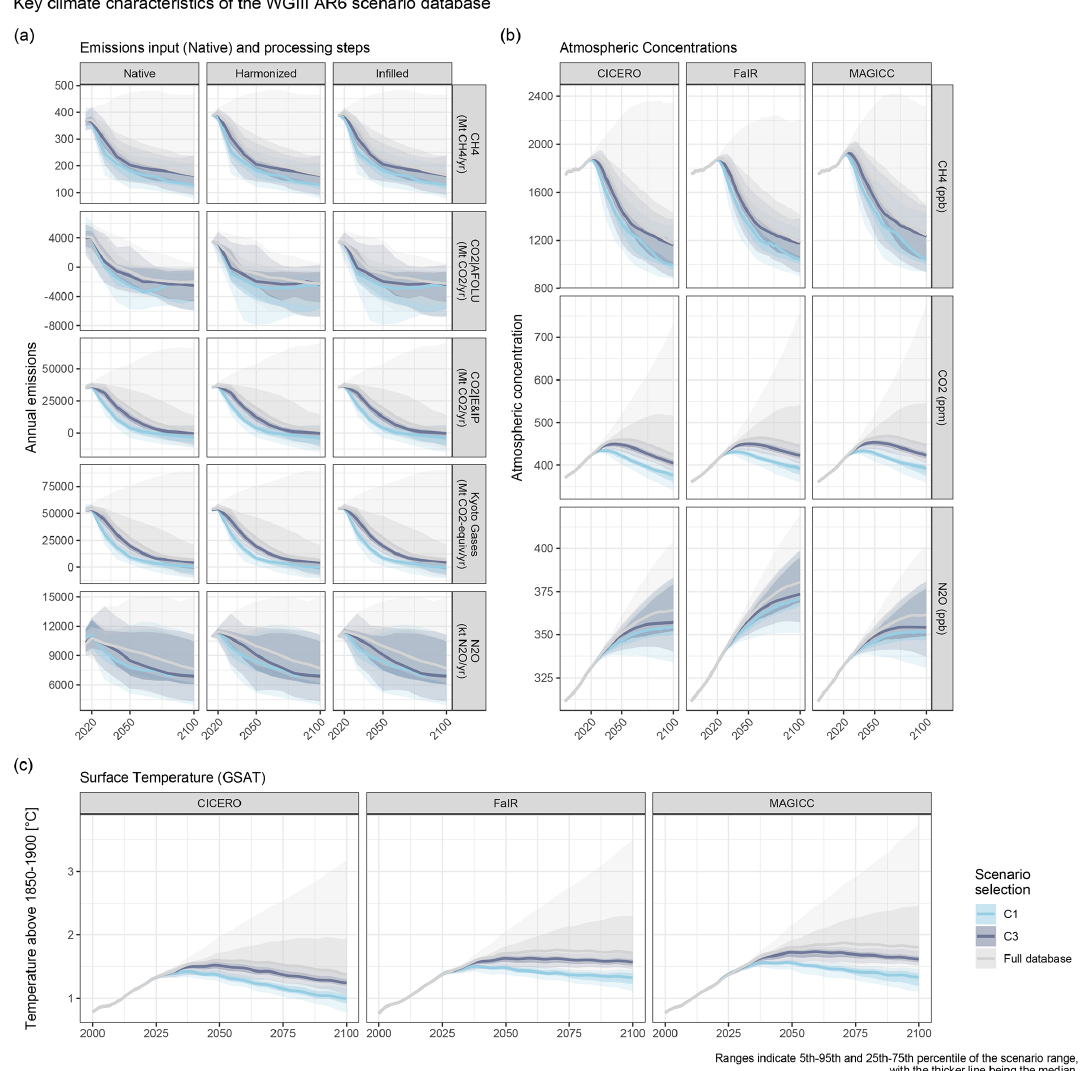
Figure 2. Summary statistics ( a : emissions, b : atmospheric concentrations, c : global mean surface temperature) over time across all scenarios in the AR6DB that received a temperature classification and across scenarios in AR6 temperature categories C1 and C3. Panel (a) shows emissions as modelled by IAMs (“Native”), after harmonisation (“Harmonized”), and after infilling missing reported emissions (“Infilled”). Panel (b) and panel (c) show climate outcomes per climate model, using the median value of each variable from the climate emulator probabilistic